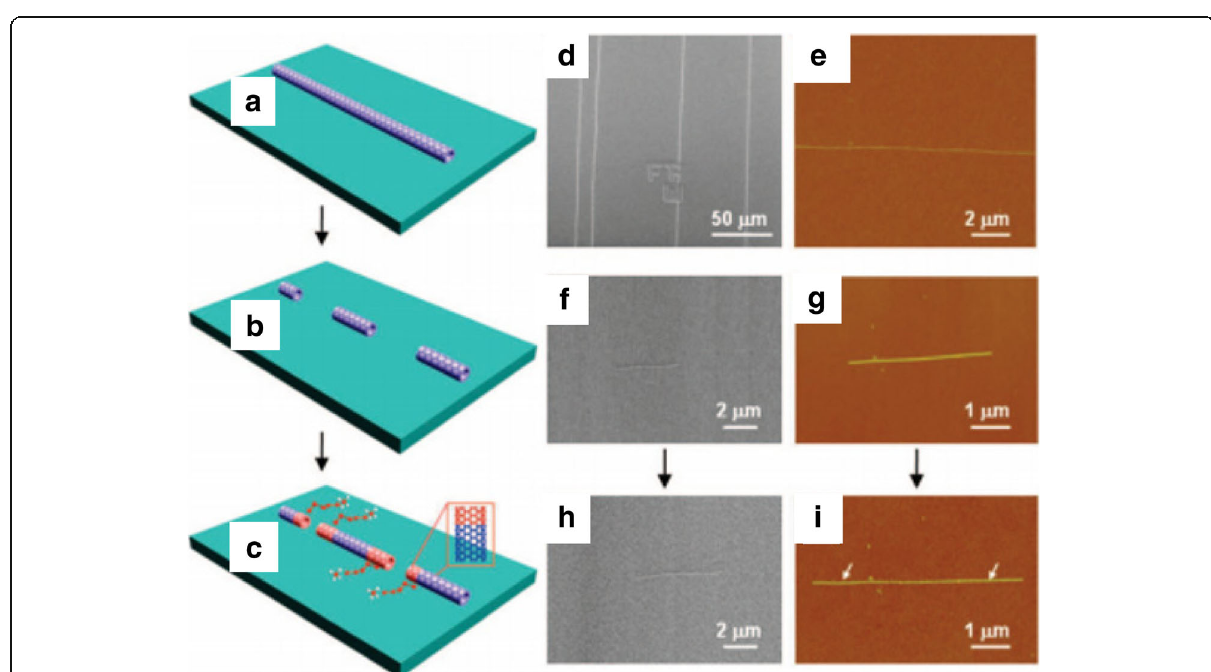
Fig. 10 a – c Schematic diagram showing the growth process of ultra-long SWCNTs using e-beam lithography cut nanotube segments as the template via ‘ cloning ’ mechanism. Adapted from [118]. d , e SEM and AFM images SWCNTs used for preparing open-end SWCNTs seeds. Adapted from [118]. f , g SEM and AFM images of short parent SWCNTs segments for the second growth Adapted from [118]. h , i SEM and AFM images of duplicate SWCNTs continued grown from the SWCNTs. Adapted from